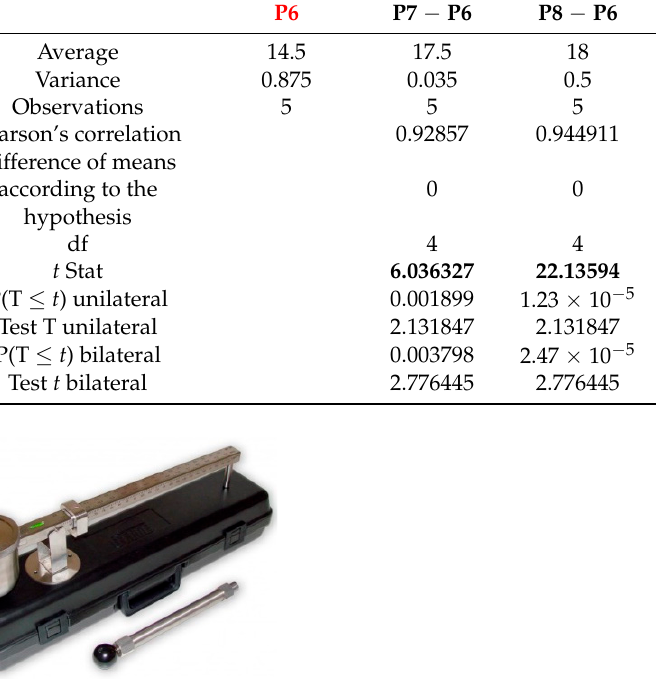
Figure 1. Baroid weight.